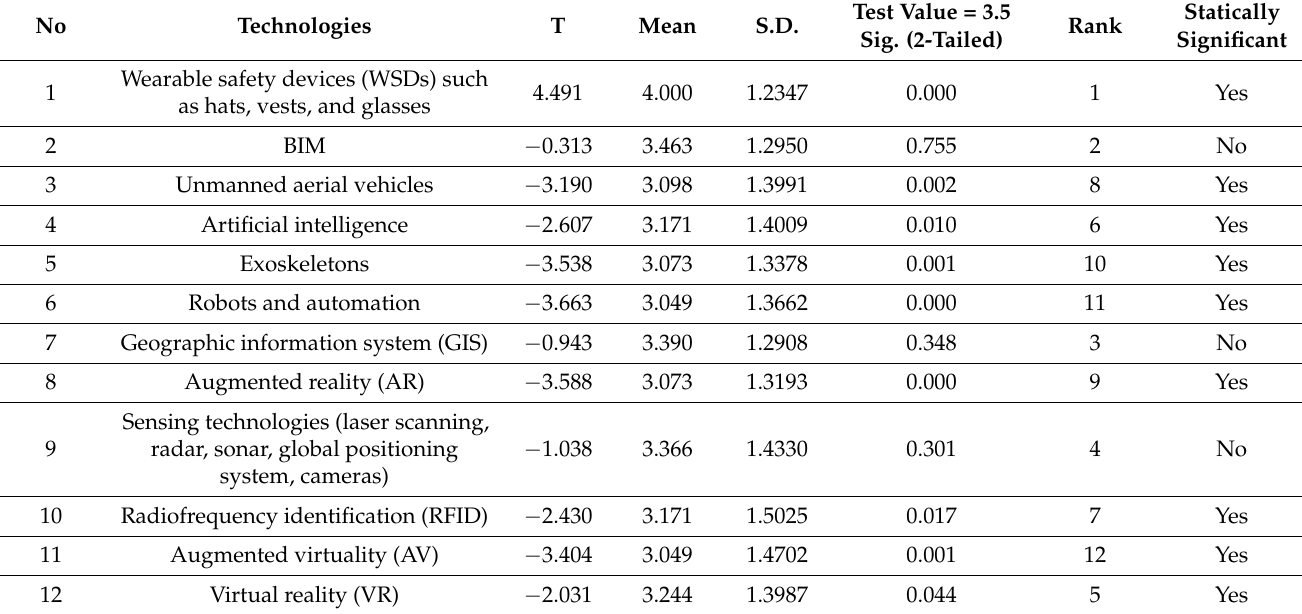
Table 3. Use of current health and safety technologies in the Ghanaian construction